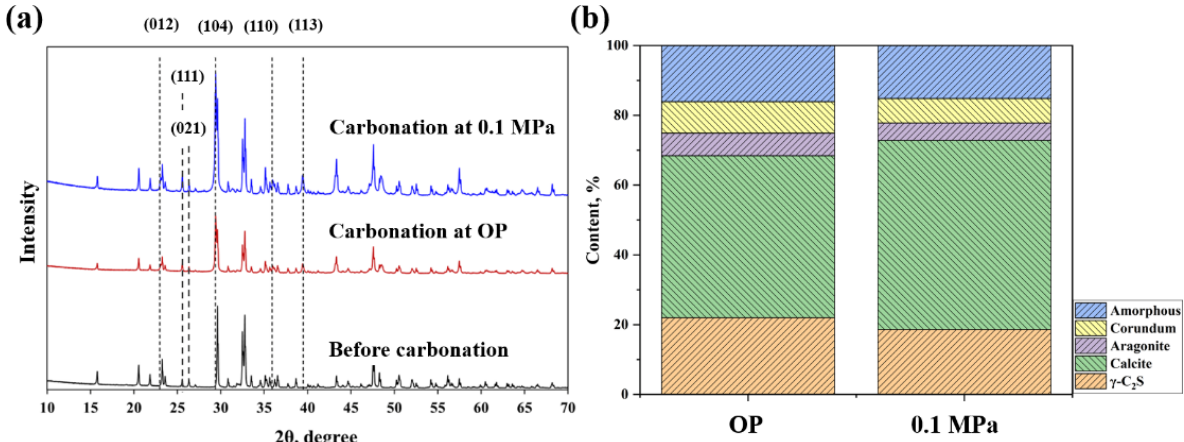
Figure 3. ( a ) XRD pattern and ( b ) the phase assemblage of carbonated coating.